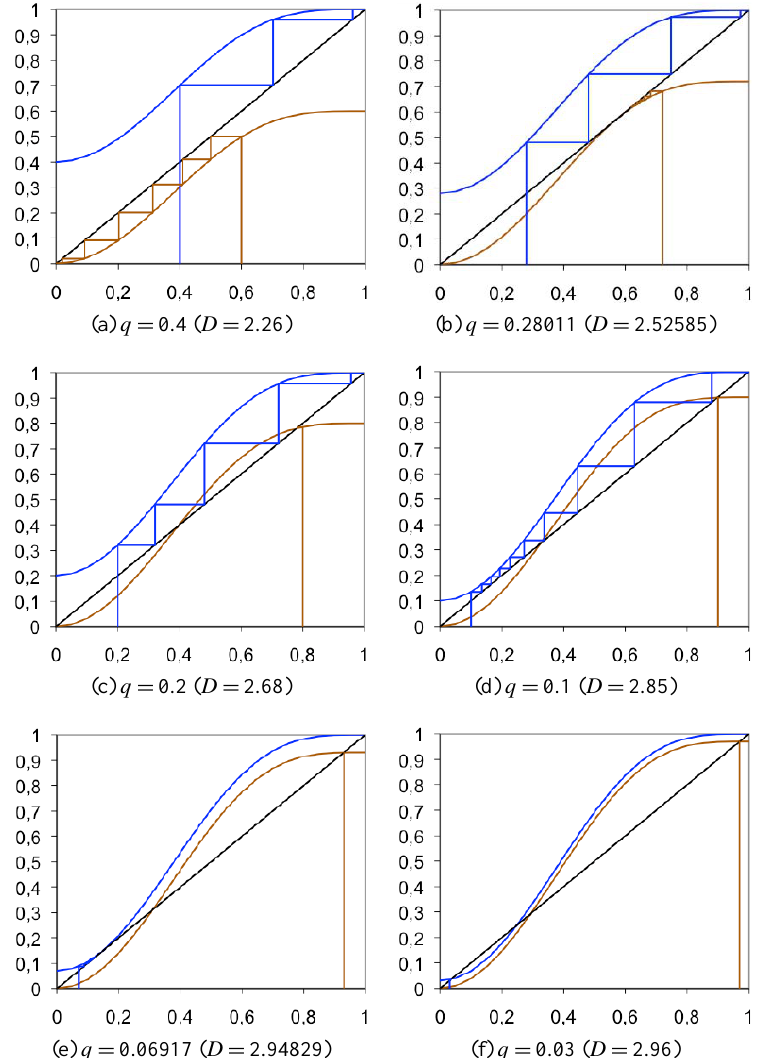
Fig. 1. Iterations using the renormalisation functions of a 3-D mass fractal defined respectively by Eq. (3) for the pore network (blue curve) and the solid network (brown curve). Figure 1a to 1f depict the results of the upscaling renormalization process for varying q , each step in the step functions plotted respectively in red or brown represents an iteration level in the fractal model using Eq.